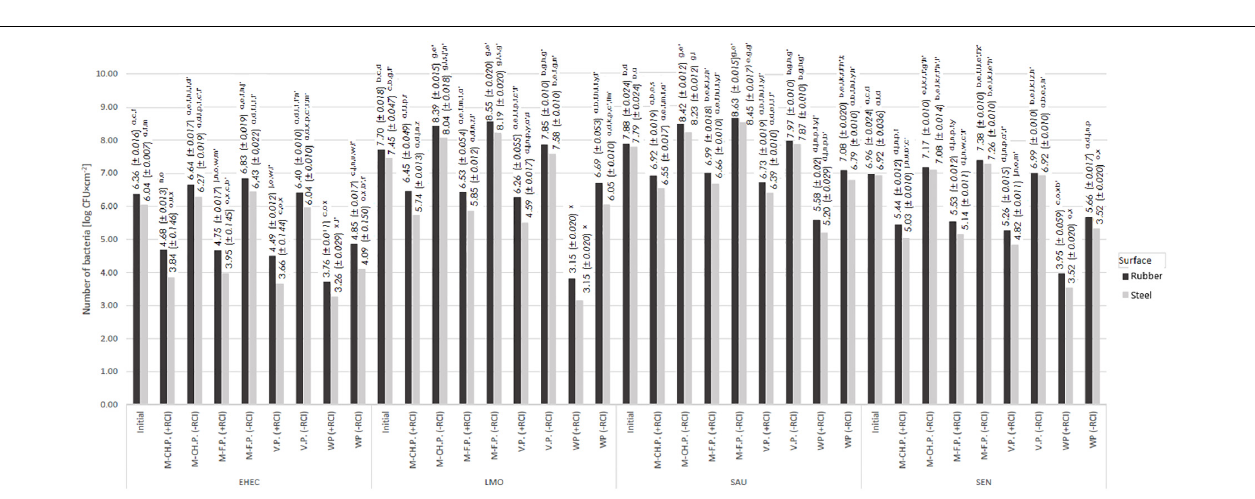
FIGURE 5 | Changes in the number of bacteria under the influence of RCI depending on the organic pollution [M-CH.P. – milk-cheese pulp, M-F.P. – meat-fish pulp, V.P. – vegetable pulp, WP – without pulp, +RCI – with RCI, − RCI – without RCI; a, b, c – values marked with different letters are significantly different ( P < 0.05); EHEC – E. coli O157:H7; LMO – L. monocytogenes ; SAU – S. aureus ; SEN – S . Enteritidis].